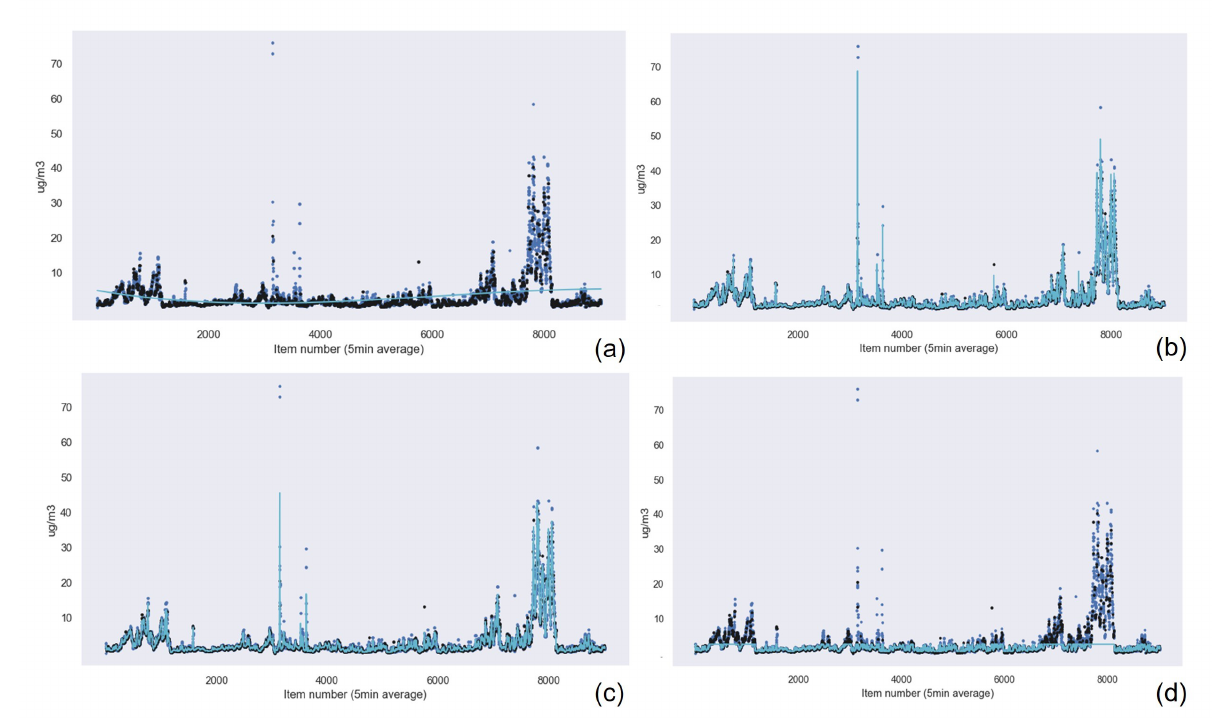
Figure A16. Cont